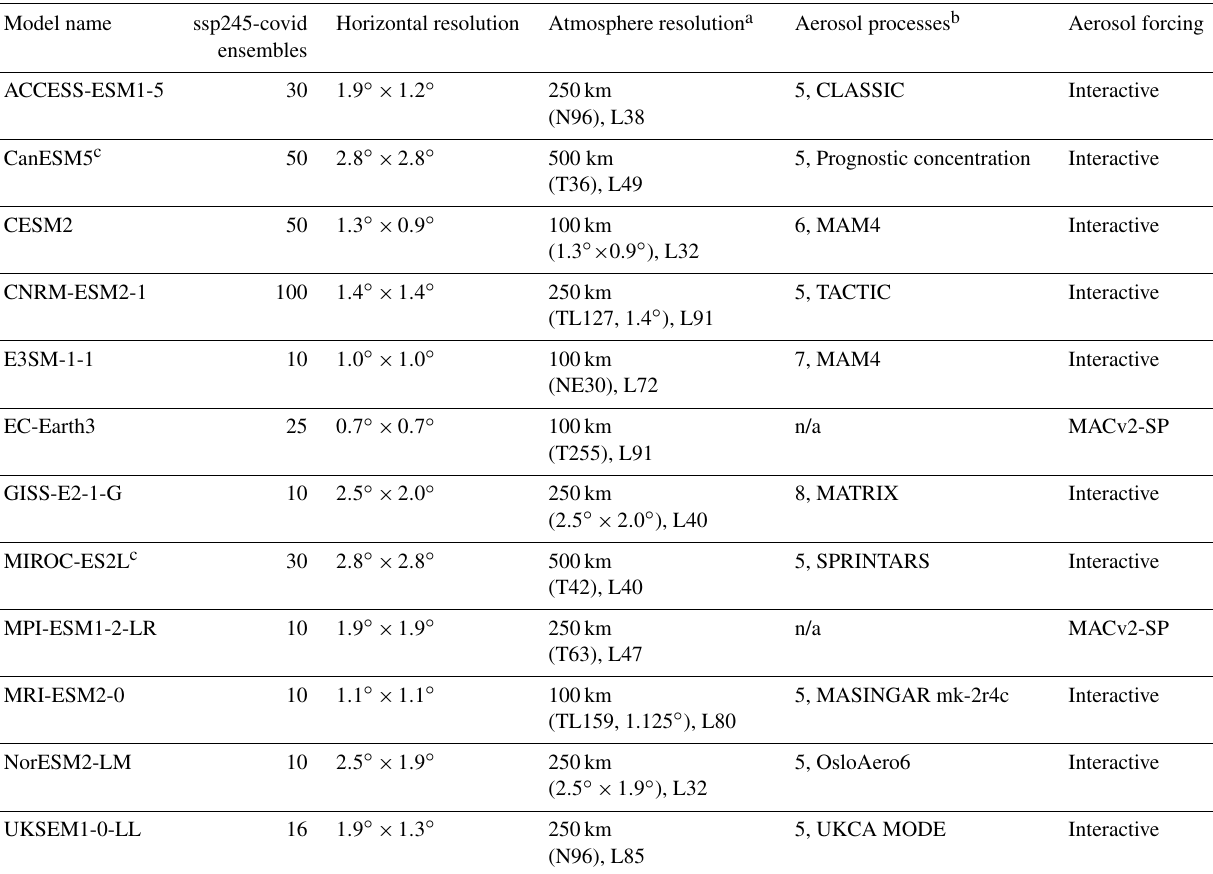
Table 1. List of CovidMIP models and their main model characteristics. Table adapted from Jones et al. (2021). Note: n/a stands for